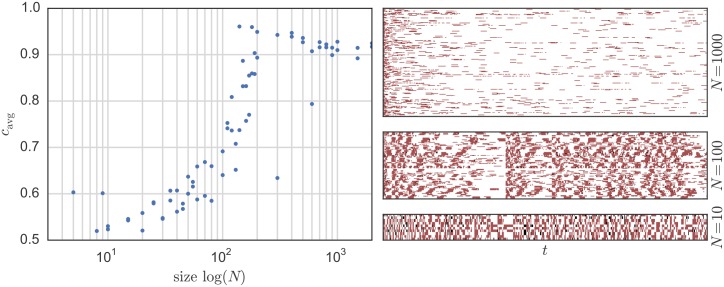
On the left: change in the average cooperation cavg depending on the system size N. On the right: examples of a typical system behavior as a function of time t where the points (pixels) represent the agent state Si[t] such that red means defection, white cooperation, and black = doing nothing for N = 1000 (top), N = 100 (middle) and N = 10 (bottom). The system parameters are: λmin = 0.0005, RV = 2Ω, R0 = R/N = 200Ω, perr = 0.01 and V = 1 V. The communication network is configured as Watts-Strogatz graph.